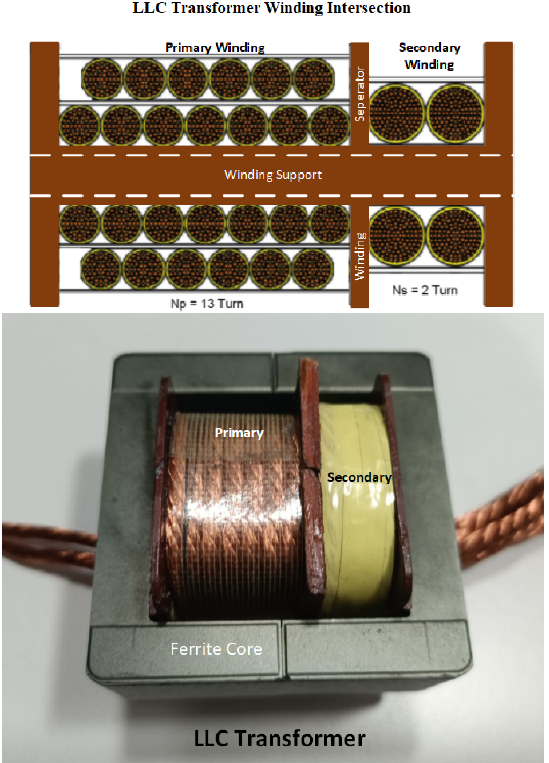
Figure 6. Winding design of LLC resonant converter